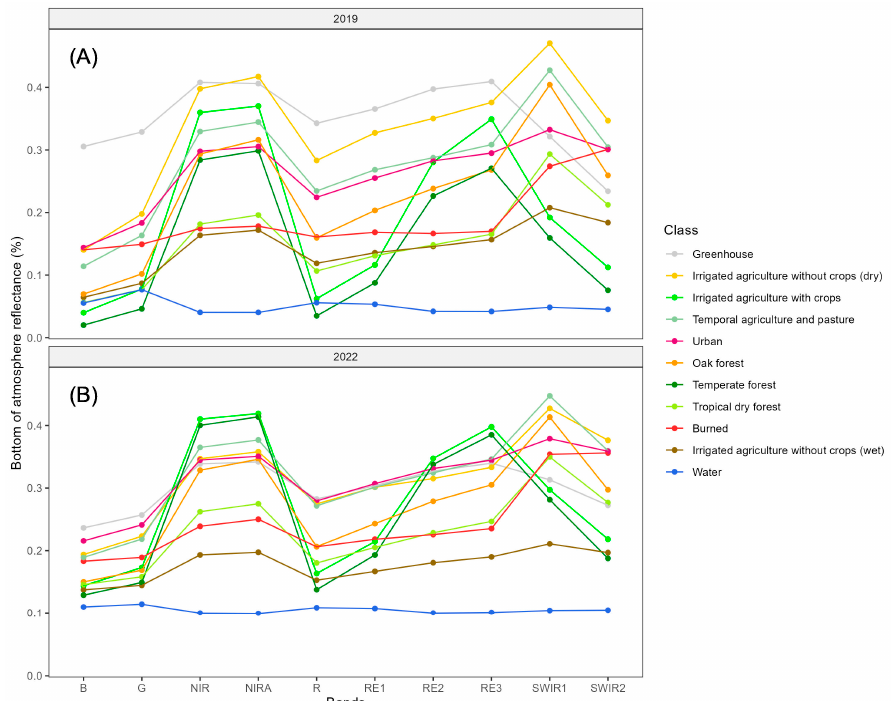
Figure 2. The distribution of the mean reflectance of the samples for the land use/land cover classes at the ten spectral bands of Sentinel-2 images for the years 2019 ( A ) and 2022 ( B ). Classes are sorted in descending order according to their mean reflectance in the NIR band in 2019. The standard deviations of the spectral reflectance range from 0.0042 to 0.142.